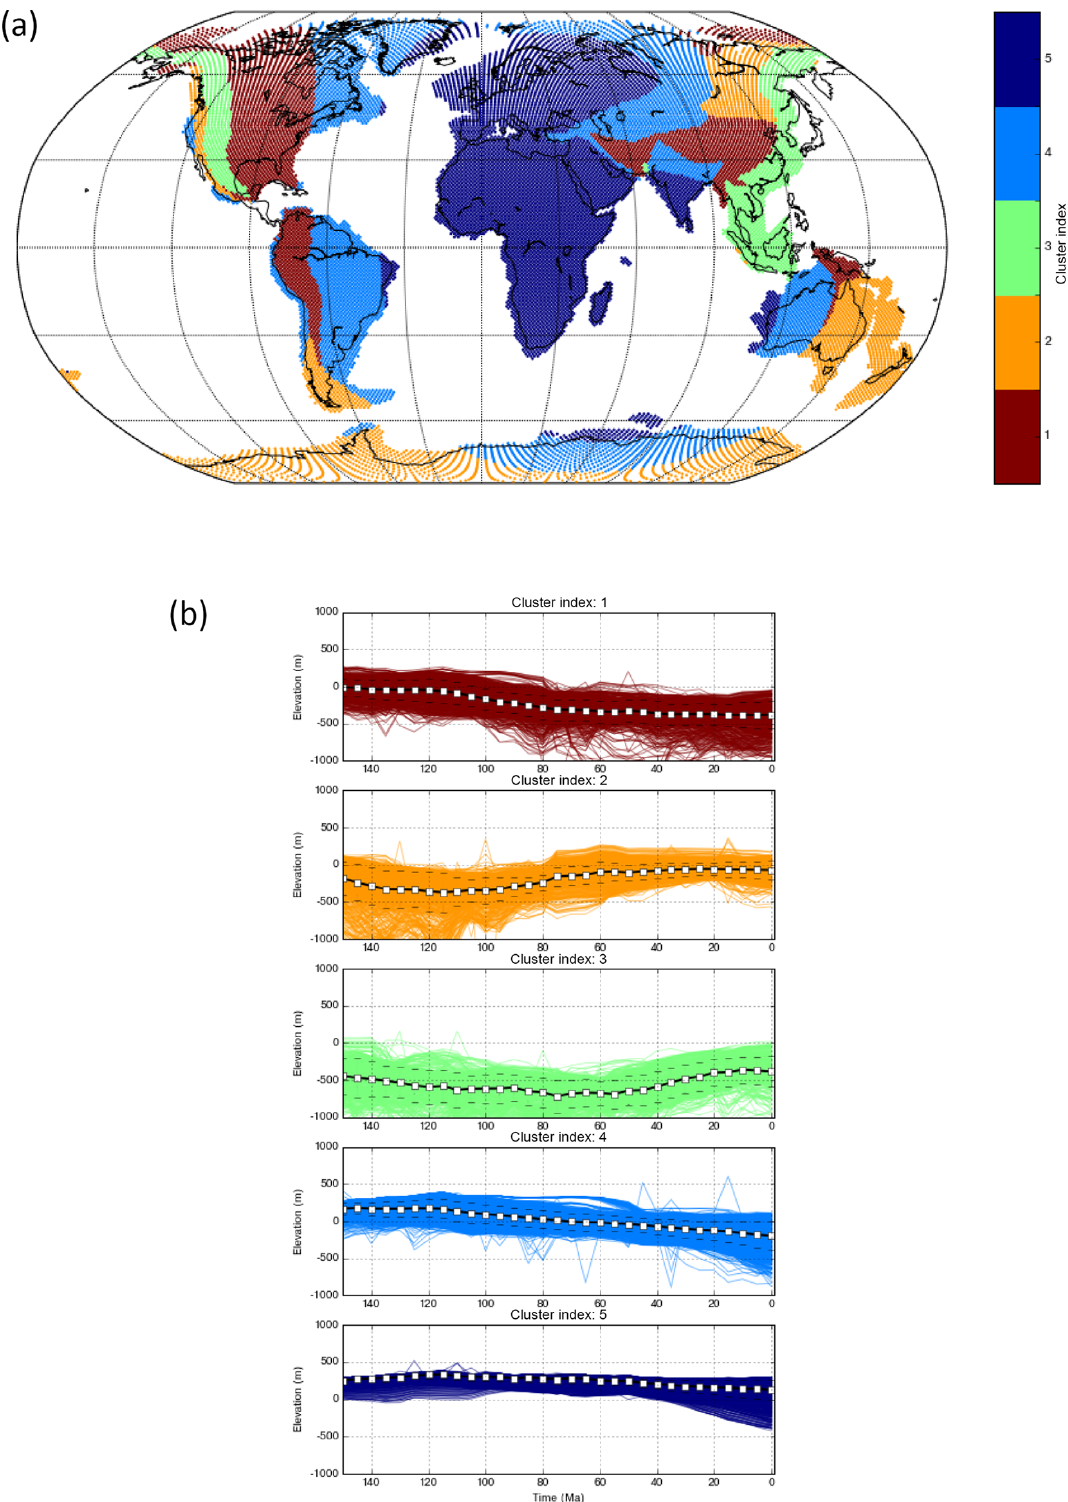
Figure 14. The cluster analysis underpins the suggested categorisation; k = 5. (a) The dark blue cluster consists of locations in stable areas, light blue corresponds to (long-term) dynamically subsiding areas and the fluctuating category is encompassed by three clusters (green, orange and red). (b) Different clusters of elevation time series. The average trend is marked in black. See the Supplement for alternative choices of k